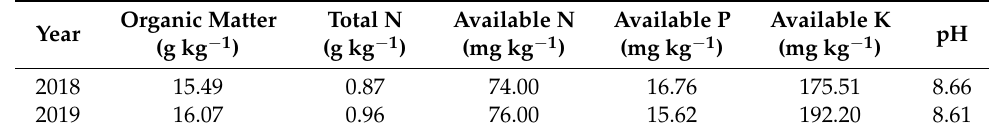
Table 1. Soil physical and chemical properties in 2018 and 2019.